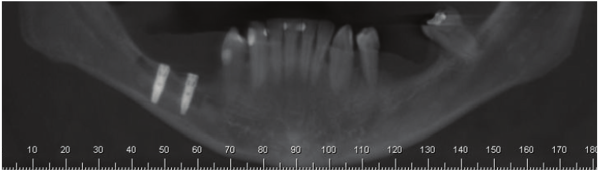
Figure 31: Panoramic court after implant placement.